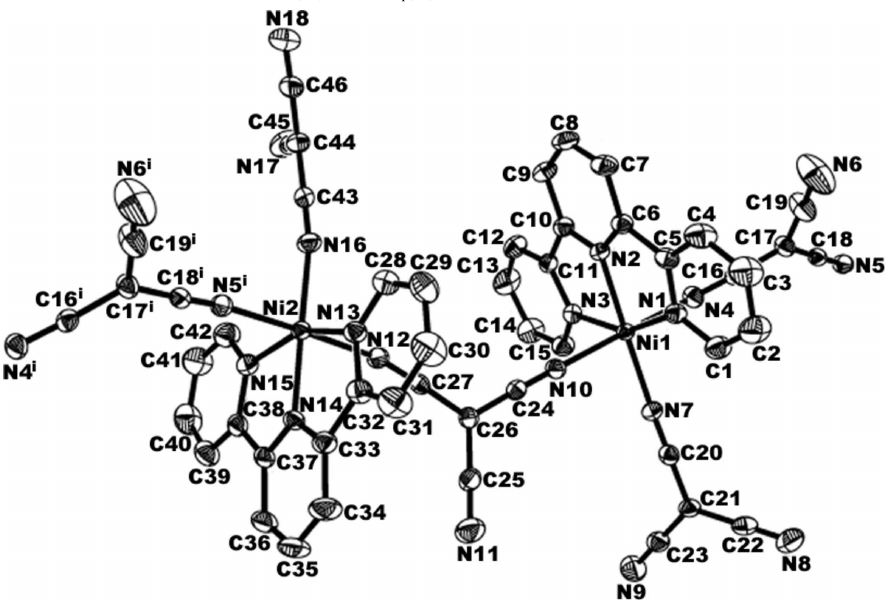
Figure 1 A view of the one-dimensional chain in (I), showing the atom-labelling scheme. Displacement ellipsoids are drawn at the 50% probability level and H atoms have been omitted for clarity [symmetry code: (i) x + 1, y + 1, z